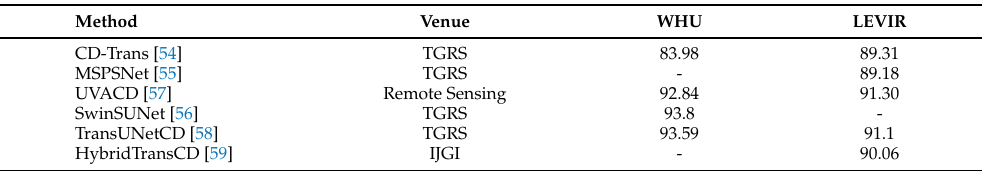
Table 3. Comparison, in terms of F1 score, of different transformer-based change detection methods on the two popular benchmarks: WHU and